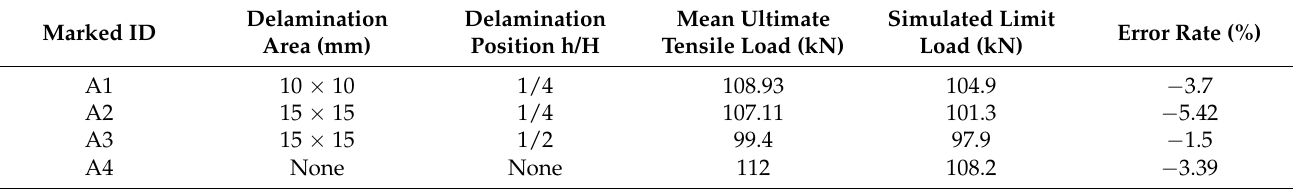
Table 5. Comparison between test results and simulation results.